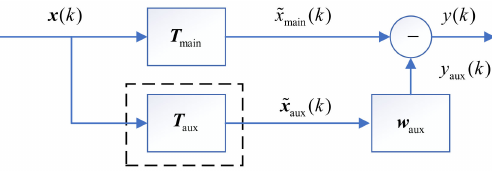
Figure 1. Framework of auxiliary channel space–time adaptive processing (STAP).